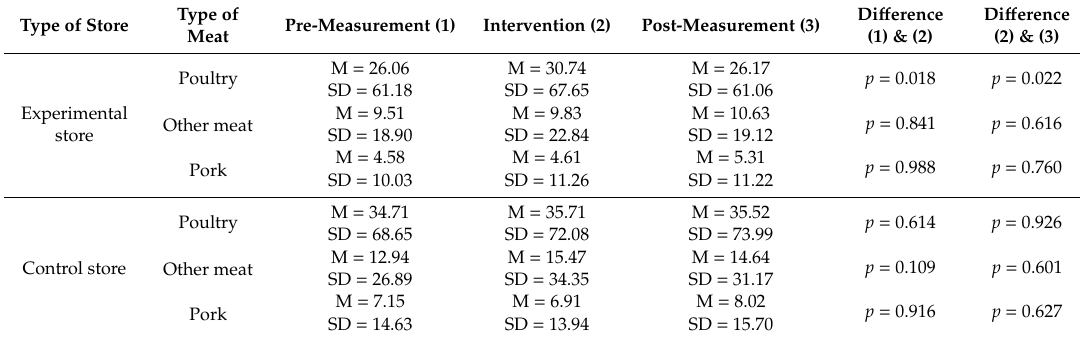
Table 2. Revenue (Euros) generated per product per